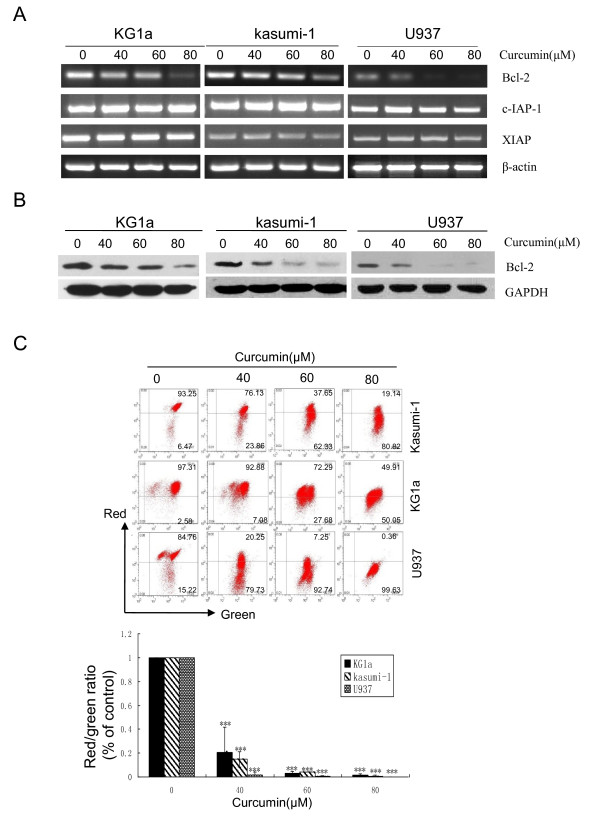
Curcumin decreased Bcl-2 mRNA and protein levels and caused the loss of MMP. KG1a, Kasumi-1 and U937 cells were exposed to different concentrations of curcumin for 24 h. (A) The effects on Bcl-2, c-IAP-1, and XIAP mRNA levels were determined by RT-PCR. (B) The effect on Bcl-2 protein levels was determined by Western blotting assay. Three independent experiments were performed with similar results, and representative data are shown. (C) MMP was estimated by flow cytometry showing decrease in the red to green fluorescence ratio. The results shown are representative of three independent experiments. The bar represents mean ± SD of three independent experiments.